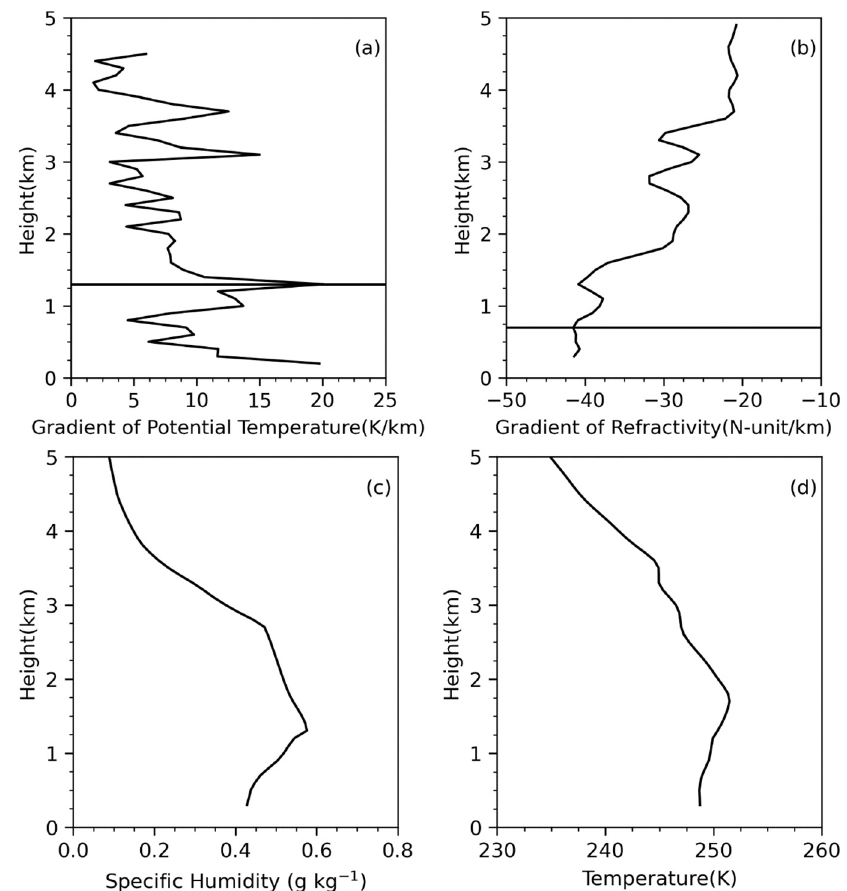
Figure 2. The radiosonde/RO co-location 2 profiles of ( a ) the potential temperature gradient and ( b ) the refractivity gradient, as well as RO2 of ( c ) the specific humidity and ( d ) the temperature. The black horizontal lines show the PBLHs. The radiosonde event occurred at 2300UTC on 11 March 2007, located at (156.8°W, 71.3°N); the radio occultation event (RO2) occurred at 2108UTC on 11 March 2007, located at (160.3°W, 71.9°N).